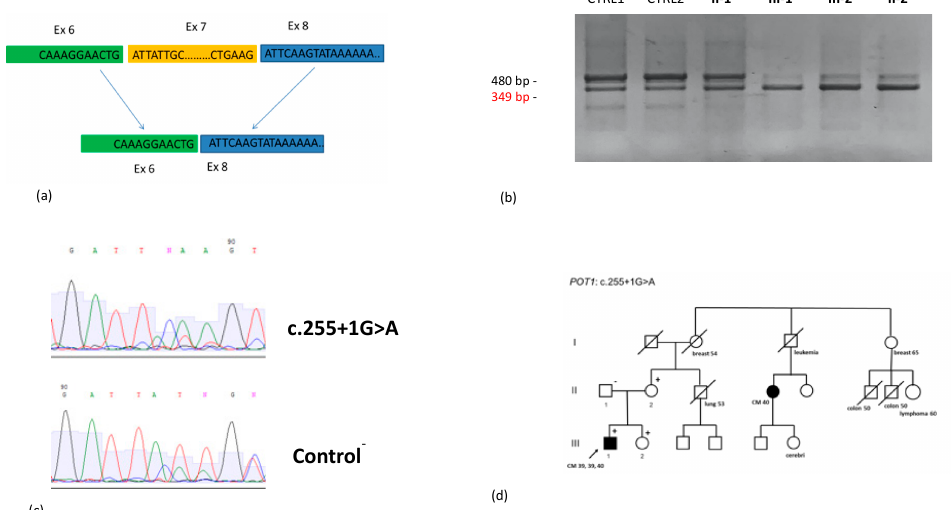
Figure 1. Pedigree with the POT1 c.255 + 1G > A variant and the resulting splicing of exon 7. ( a ) Schematic representation of the splicing of exon 7 (113bp) owing to the c.255 + 1G > A variant. ( b ) Electrophoresis of the cDNA from the four family members, including three (the a ff ected proband, sister, and mother) who carry the variant c.255 + 1G > A; the father from the una ff ected branch of the family who does not carry the variant; and two healthy controls (CTRL-), showing two di ff erent transcripts, the shortest resulting from the skipping of exon 7, and overrepresented in carriers compared with non-carriers. ( c ) cDNA sequencing confirmed that the mutant allele produced the shorter isoform, with skipping of exon 7, in a higher proportion of the transcript in carriers vs. non-carriers. The blue arrow indicates the lower relative abundance of the spliced isoform (ex 6–8) in noncarriers vs. carriers (red arrow). ( d ) Pedigree diagram of the family carrying the c.255 + 1G > A variant. Dark symbol: cutaneous melanoma (CM). Cancer type and age at diagnosis are indicated under each symbol. The proband is indicated by an arrow. + : carrier, − :